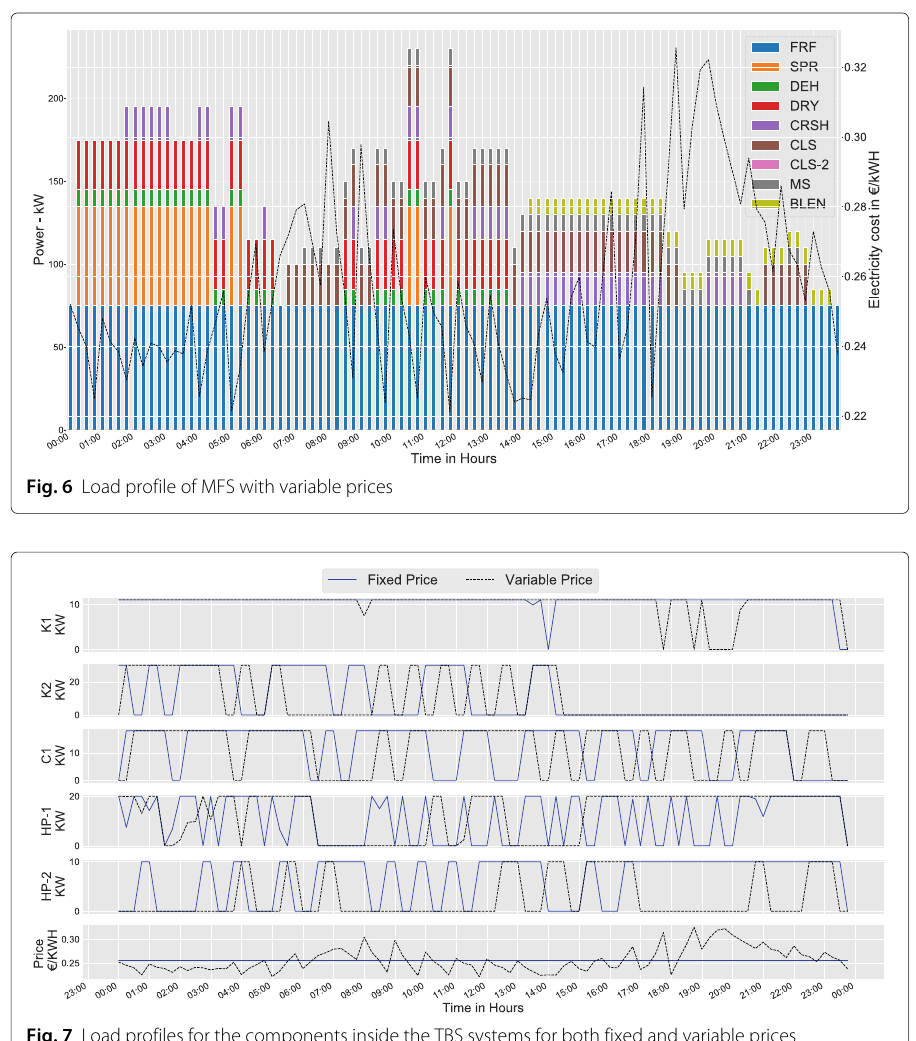
Fig. 7 Load profiles for the components inside the TBS systems for both fixed and variable prices